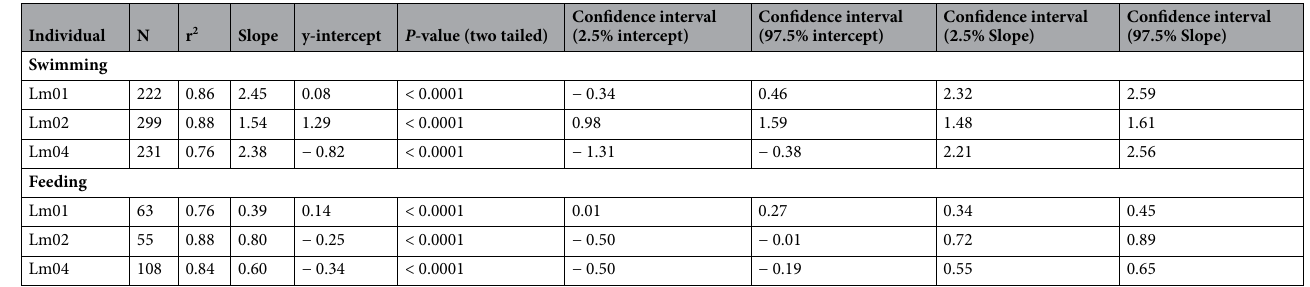
Table 1. Summary of major axis regression